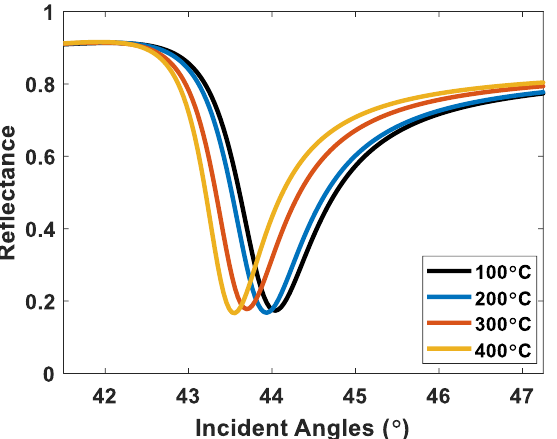
Figure 7. SPR reflectance spectra simulated using the proposed procedure at different roughness parameters reported by Yang et al. [56].